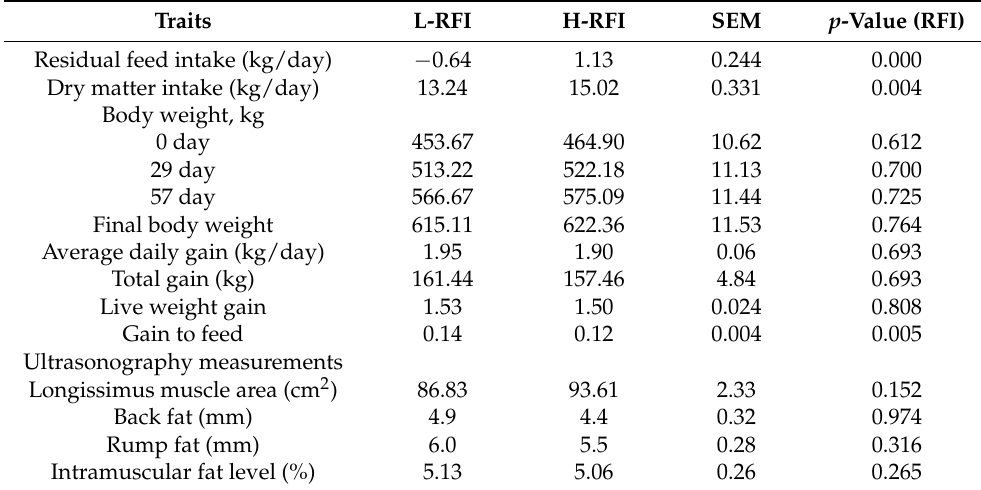
Table 2. Performance traits of animals with low (L-RFI) and high RFI (H-RFI). Traits L-RFI H-RFI SEM p -Value (RFI) Residual feed intake (kg/day) −